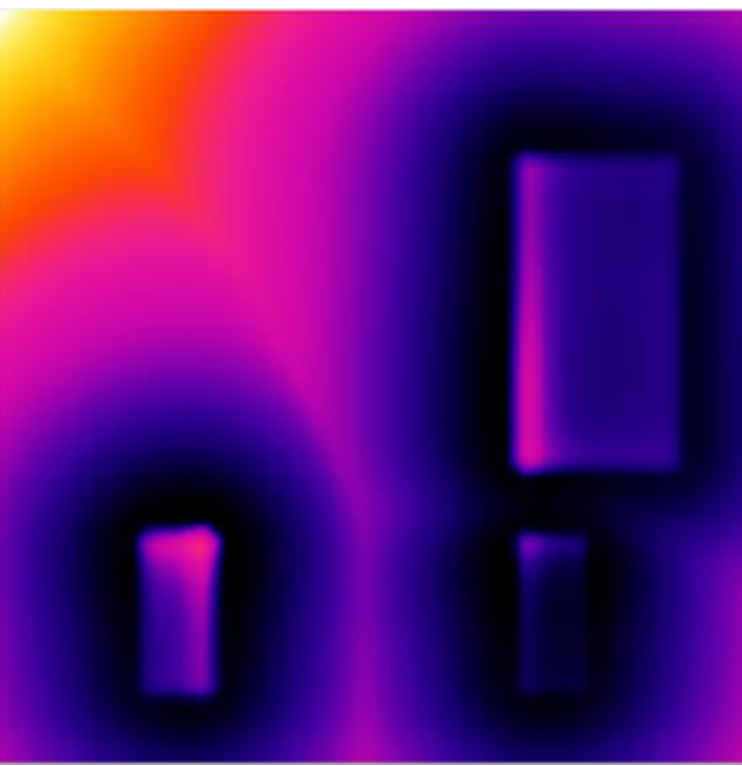
Figure 8. Image of the thermogram from Figure 6 after analysis using the Fourier transform for the 14th harmonic.